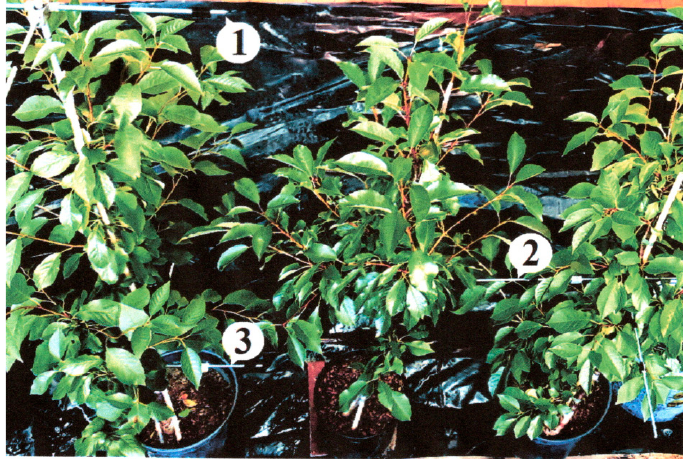
Figure 2. View of cherry trees with rod levels marked.